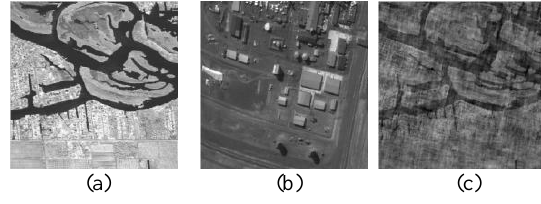
Figure 3. The importance of phase information of images. (a) the image I . (b) the image I . (c) the synthetic a b